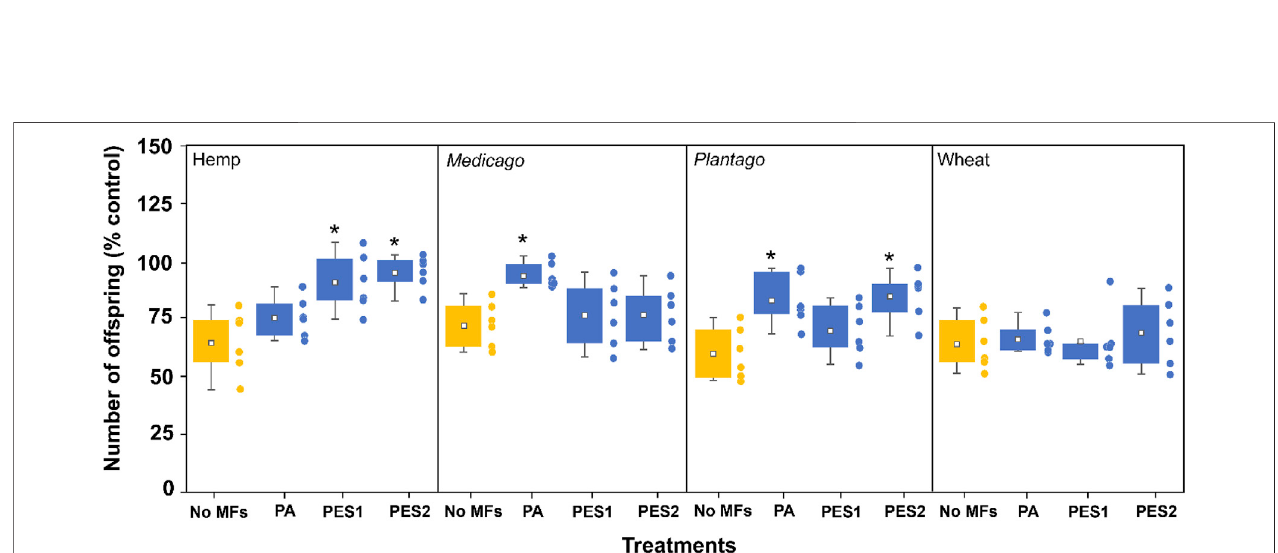
FIGURE 2 | Effects of the combinations of each MF (PA, PES1, and PES2) and different types of plant litter (hemp, Medicago , Plantago , and wheat) on nematode reproduction(numberofoffspring)intheincubatedsoils.Alldataarenormalized tocontrolgroup(%control),andthedataforsingletreatmentsofeachtypeofplantlitter (yellow bars) are adopted from Figure 1 . The asterisks (*) indicate signi fi cant ( p < 0.05) differences compared to single treatments of each plant litter. Tukey ’ s multiple comparison tests were used after one-way analyses of variance.